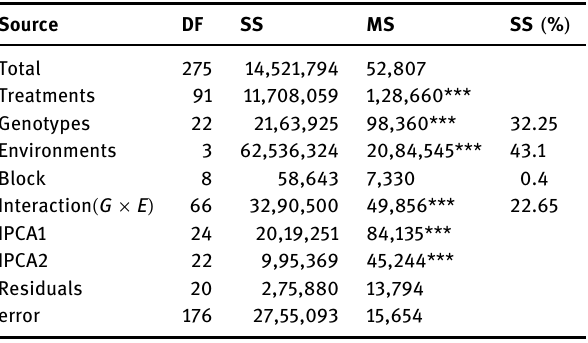
Table 3: Combined analysis of AMMI model for seed yield ( g/plant ) in three environments and the proportion of the total variance attributable to the source of